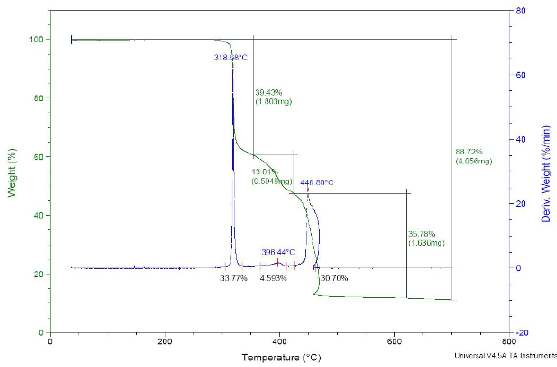
Figure 2. PXRD patterns for {[Ni II (cyclam)](carmoisine dianion)} ( 5 ) and for starting materials.